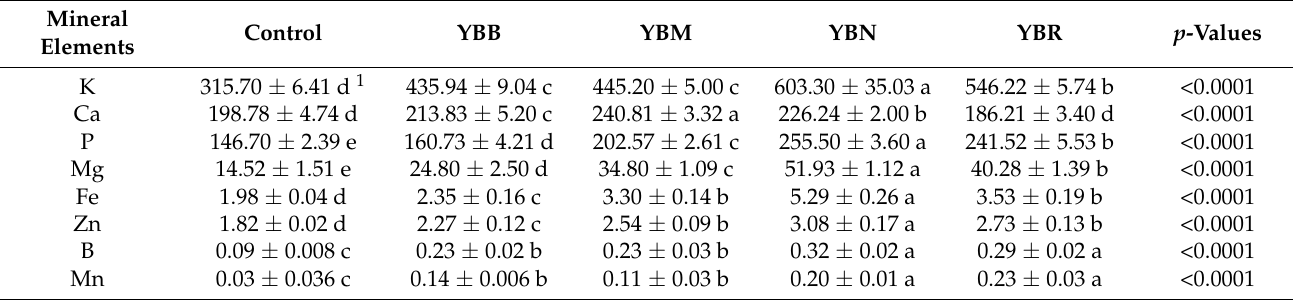
Table 6. Mineral element composition of yogurt bites, mg · 100 g − 1